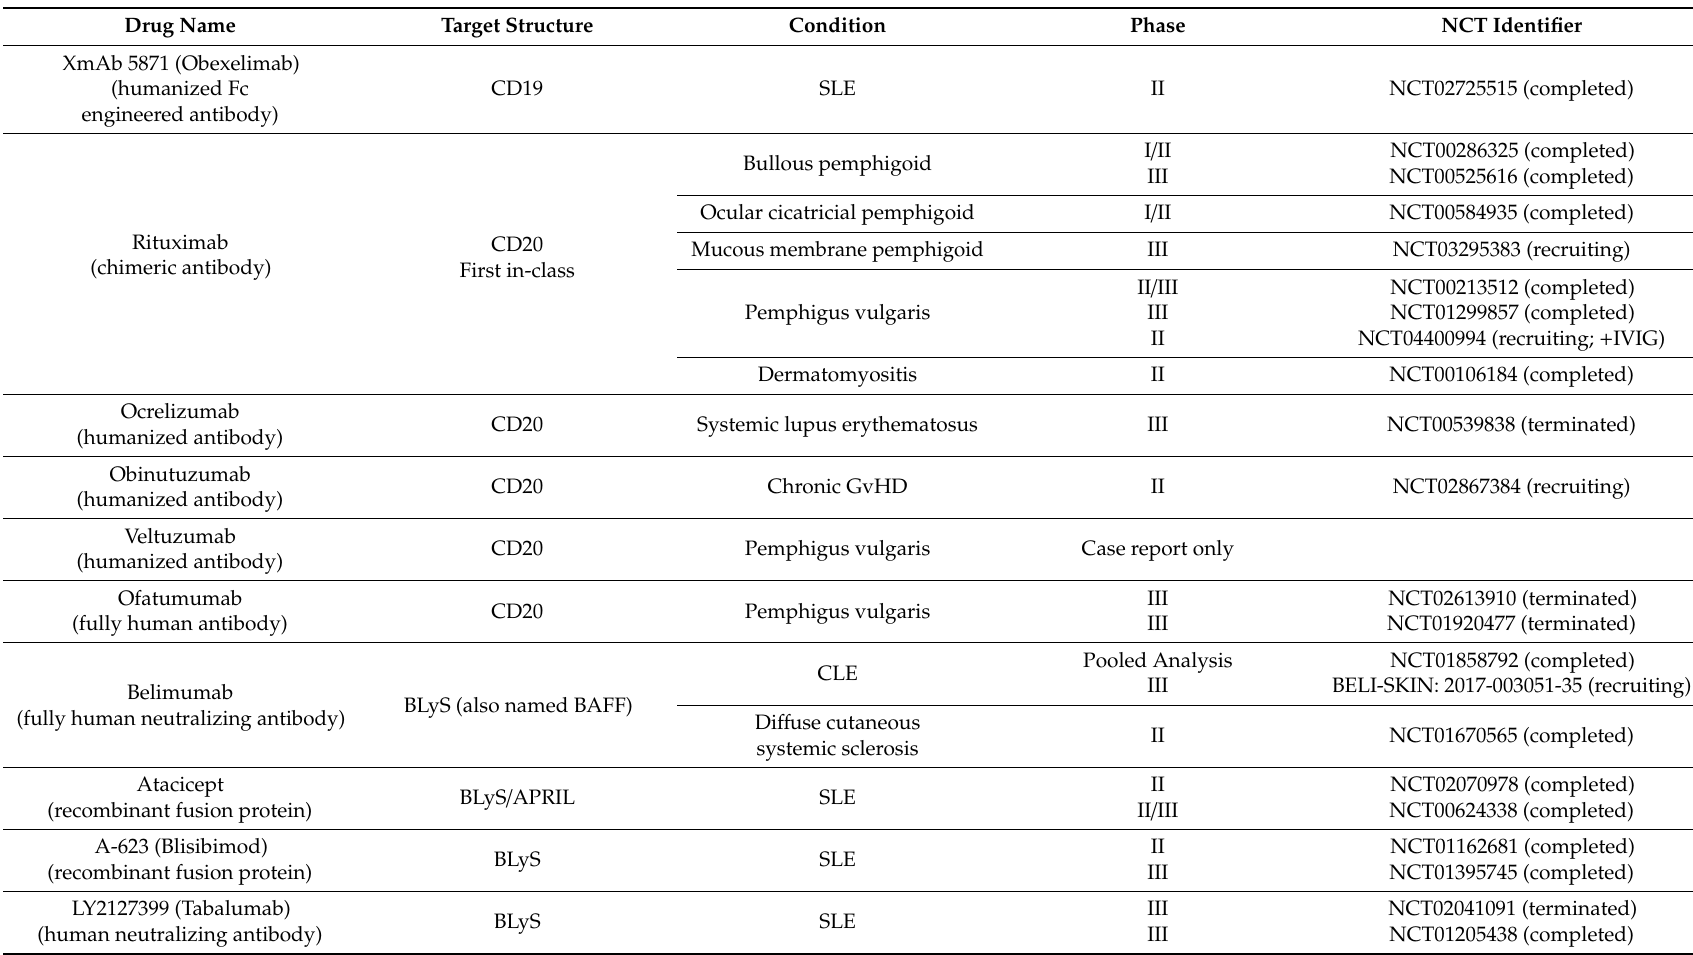
Table 2. Exemplary clinical trials of B-cell- and PC-directed therapies in miscellaneous inflammatory skin diseases as of October